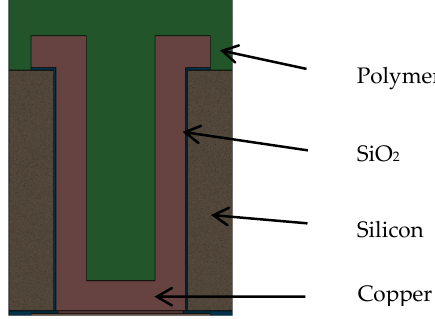
Figure 3. Schematic of TSV structure of Type A.